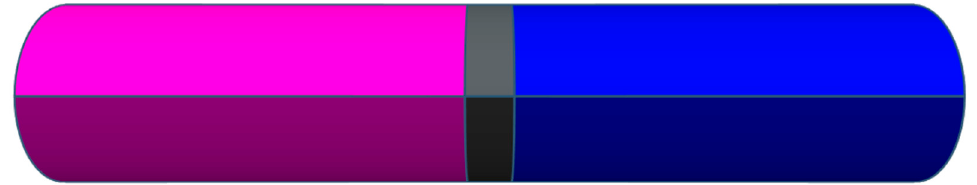
respectively) and their connecting cell wall (grey). Z-scans always started from the bright, upper